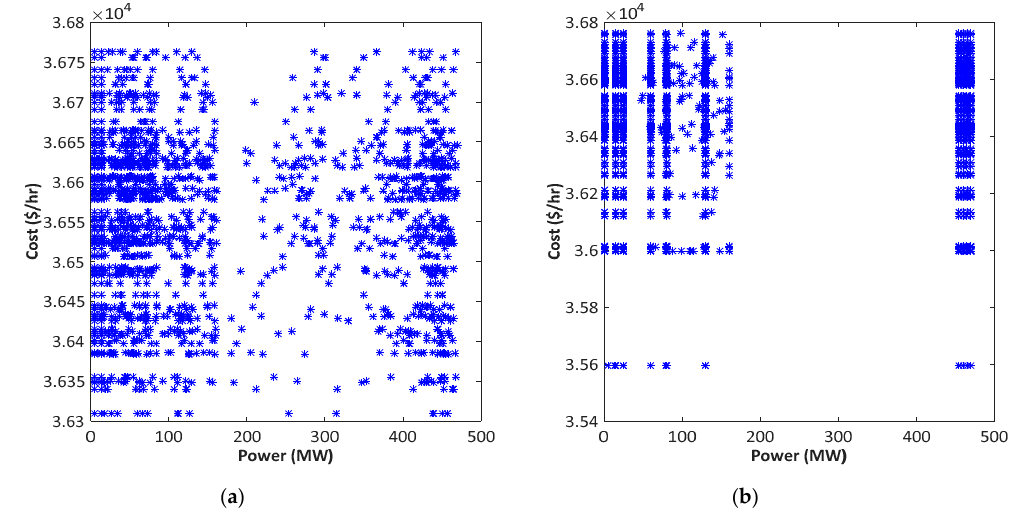
Figure 13. Bats positions in the BA ( a ) at the start and ( b ) after 1000 iterations (15-unit system with renewables).